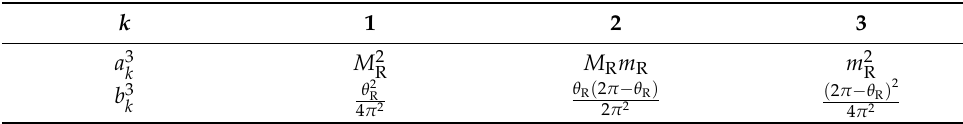
Table 3. Probability mass function of D i